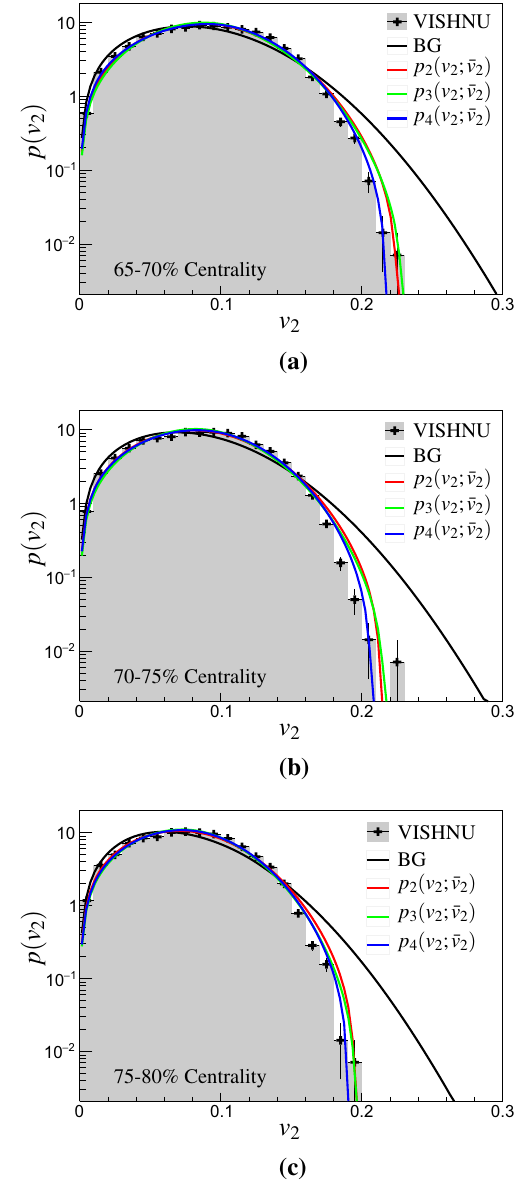
Fig. 1 Comparing the harmonic distribution of the flow from iEBE- VISHNU (shaded region) and the Gram-Charlier A series different approximations